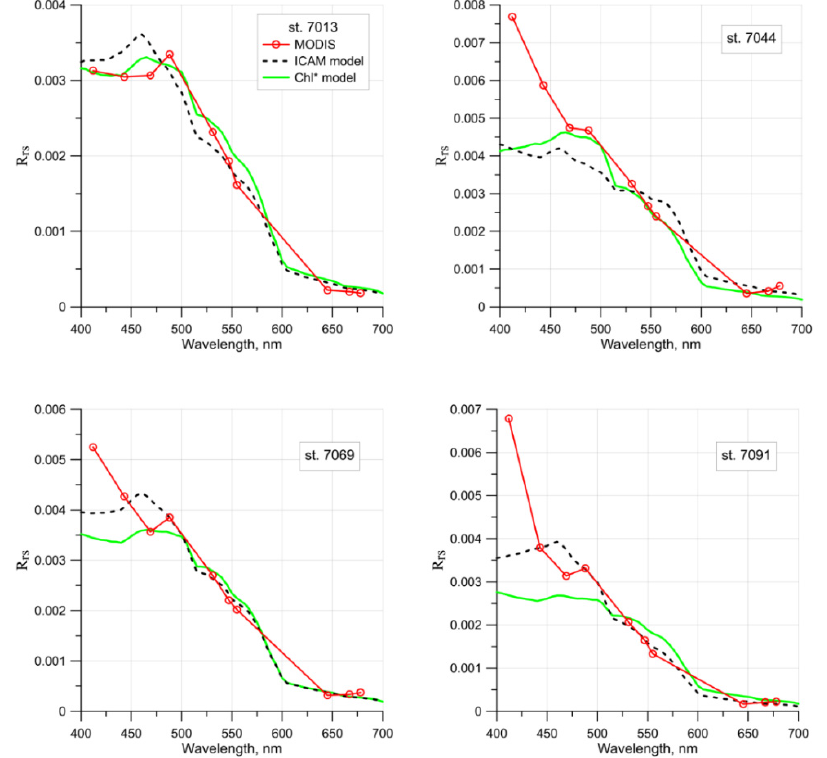
Figure 2. R rs spectra obtained from MODIS data and as a result of modelling with ICAM and Chl* data for stations 7013, 7044, 7069 and 7091 (Table 1, Figure